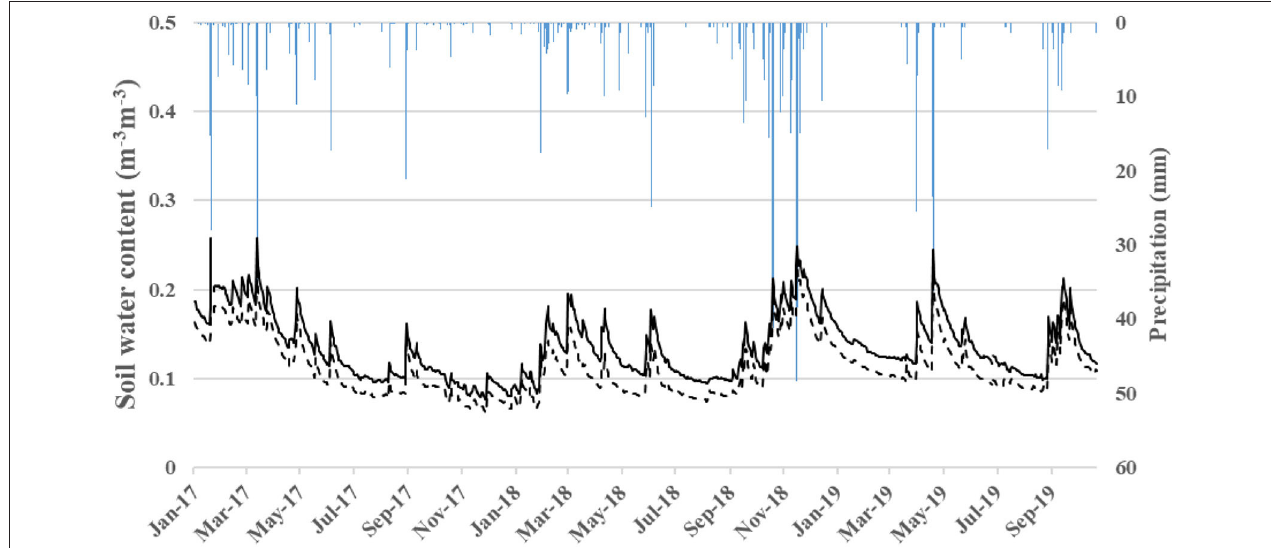
TABLE 4 | Soil characteristics at the experimental plots. Soil layer